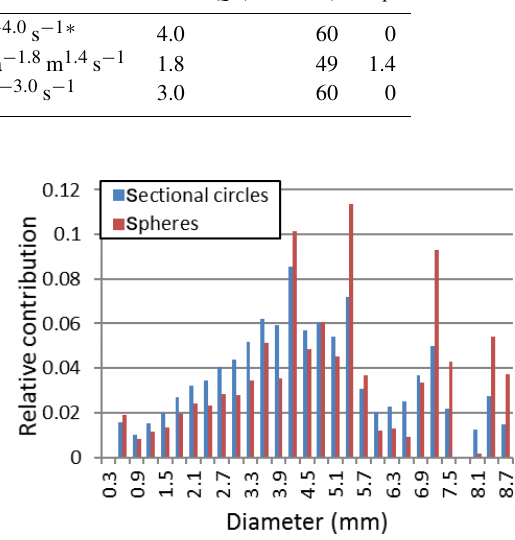
Figure 5. Relative contribution of each grain size class to the bulk volume of an ice core section containing 965 grains at 921m depth calculated for sectional circles (blue) and spherical grains (red) us- ing the method of Heilbronner and Bruhn